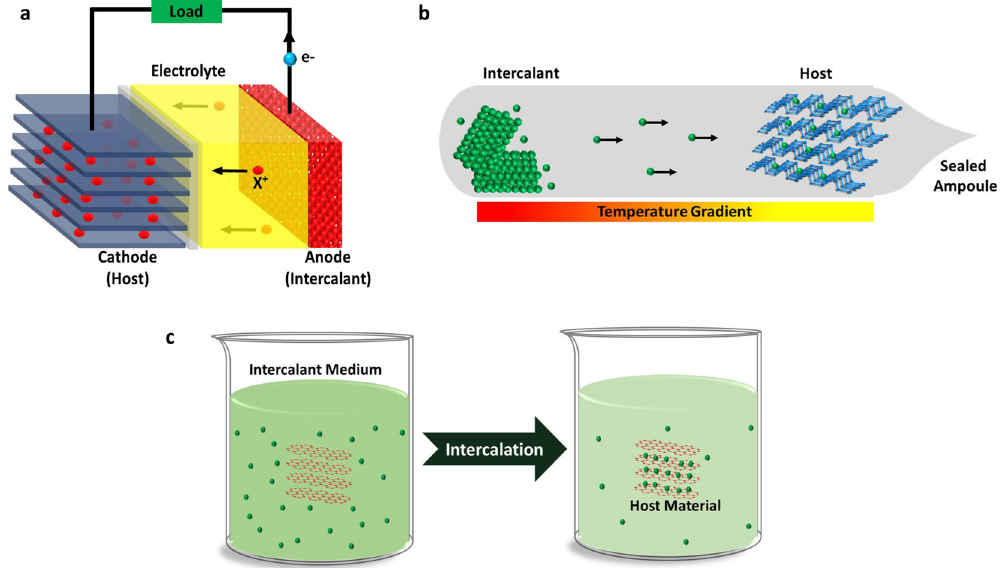
Fig. 2 Intercalation methods. a Electrochemical intercalation, b two-zone vapor phase intercalation, c liquid/solution phase